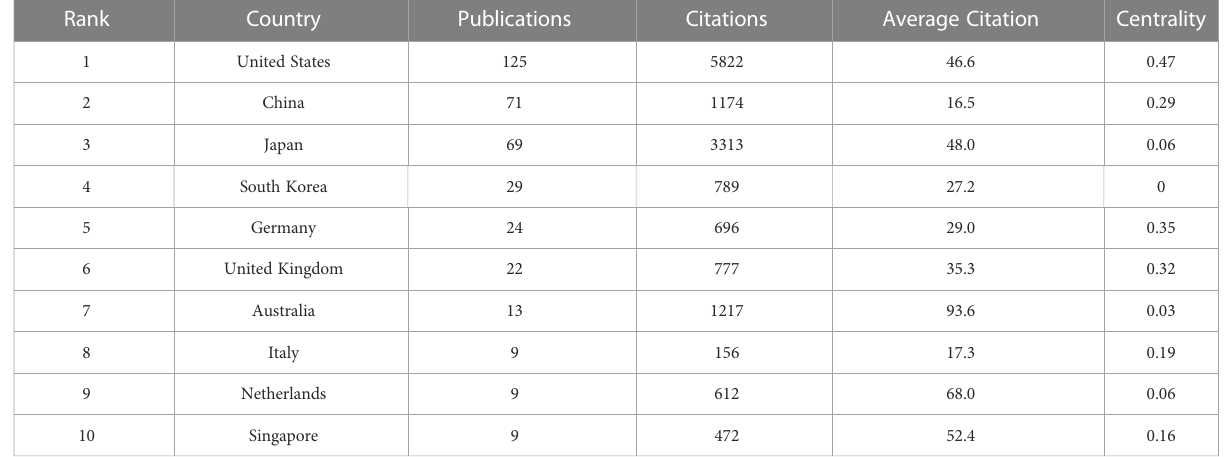
TABLE 1 The top 10 productive countries involved in SPEM-GC research.